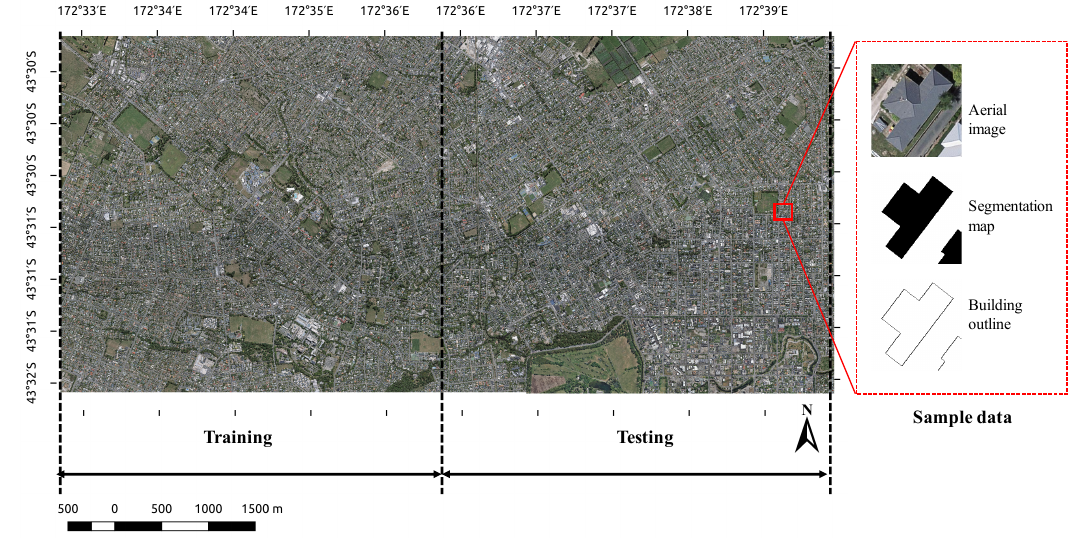
Figure 1. Aerial imagery of the study area ranging from 172 ◦ 33 (cid:48) E to 172 ◦ 40 (cid:48) E and 43 ◦ 30 (cid:48) S to 43 ◦ 32 (cid:48) S.